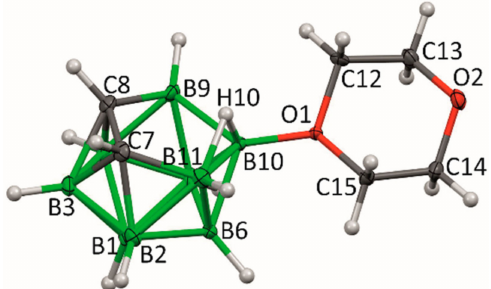
Figure 1. The molecular structure of 1 , ORTEP diagram, 30% probability level. Selected interatomic distances [Å] and angles [ ◦ ]: O1 C12 1.484(2), O1 C15 1.490(2), O1 B10 1.518(3), B10 B6 1.771(3), B10